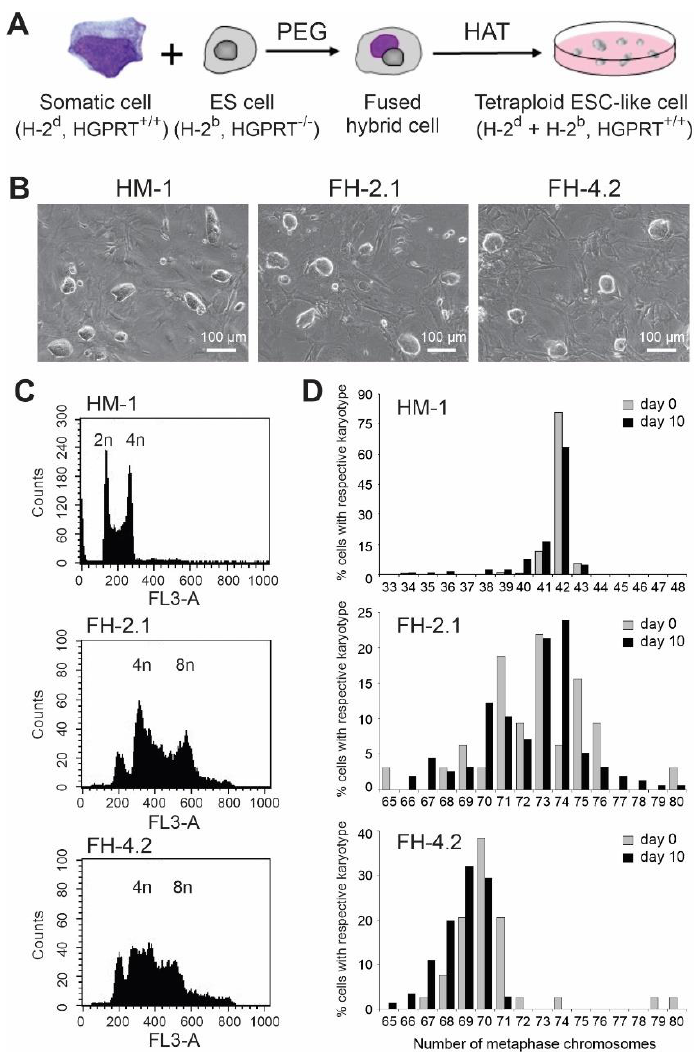
Figure 1. Characterization of fusion-derived hybrid (FH) cells. ( A ) Scheme summarizing the process of fusion-based reprogramming of bone marrow cells and splenocytes using PEG and subsequent selection with HAT to remove unfused embryonic stem cells (ESCs). Fusion partners were selected from two different mouse strains to be distinguishable by their MHC class I haplotypes and SNPs. ( B ) Colonies of the original HM-1 ESC line, bone marrow cell-derived (FH-2.1), and splenocyte- derived (FH-4.2) fusion clones. Scale bars: 100 μM. ( C ) DNA content analysis of undifferentiated ESCs and fusion-hybrid-derived pluripotent stem cells (FH-PSCs) as determined by flow cytometry of propidium iodide stained cells. ( D ) Karyotype analysis of undifferentiated ESCs and FH-PSCs and their respective differentiating cells isolated from embryoid bodies (EBs) at day 10 of differen- tiation (see also Figure S1 for a representative spread of metaphase chromosomes).